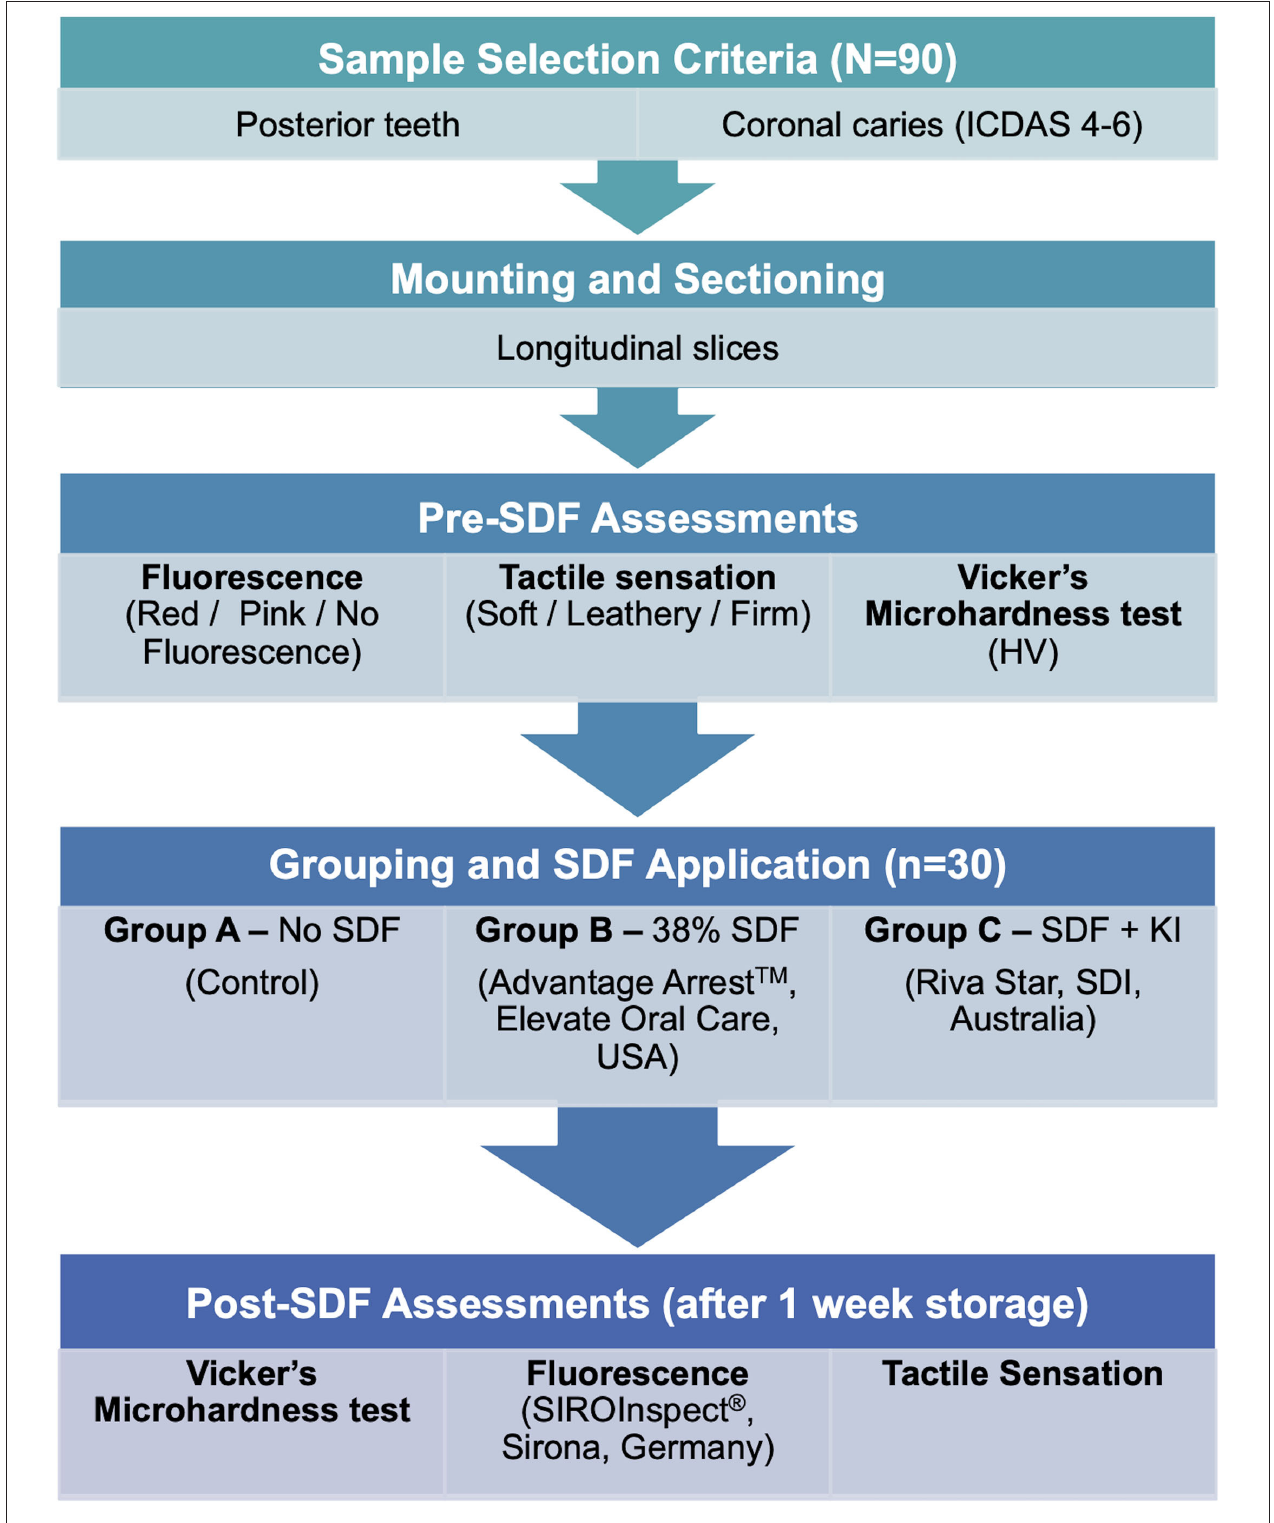
FIGURE 2 | Study design